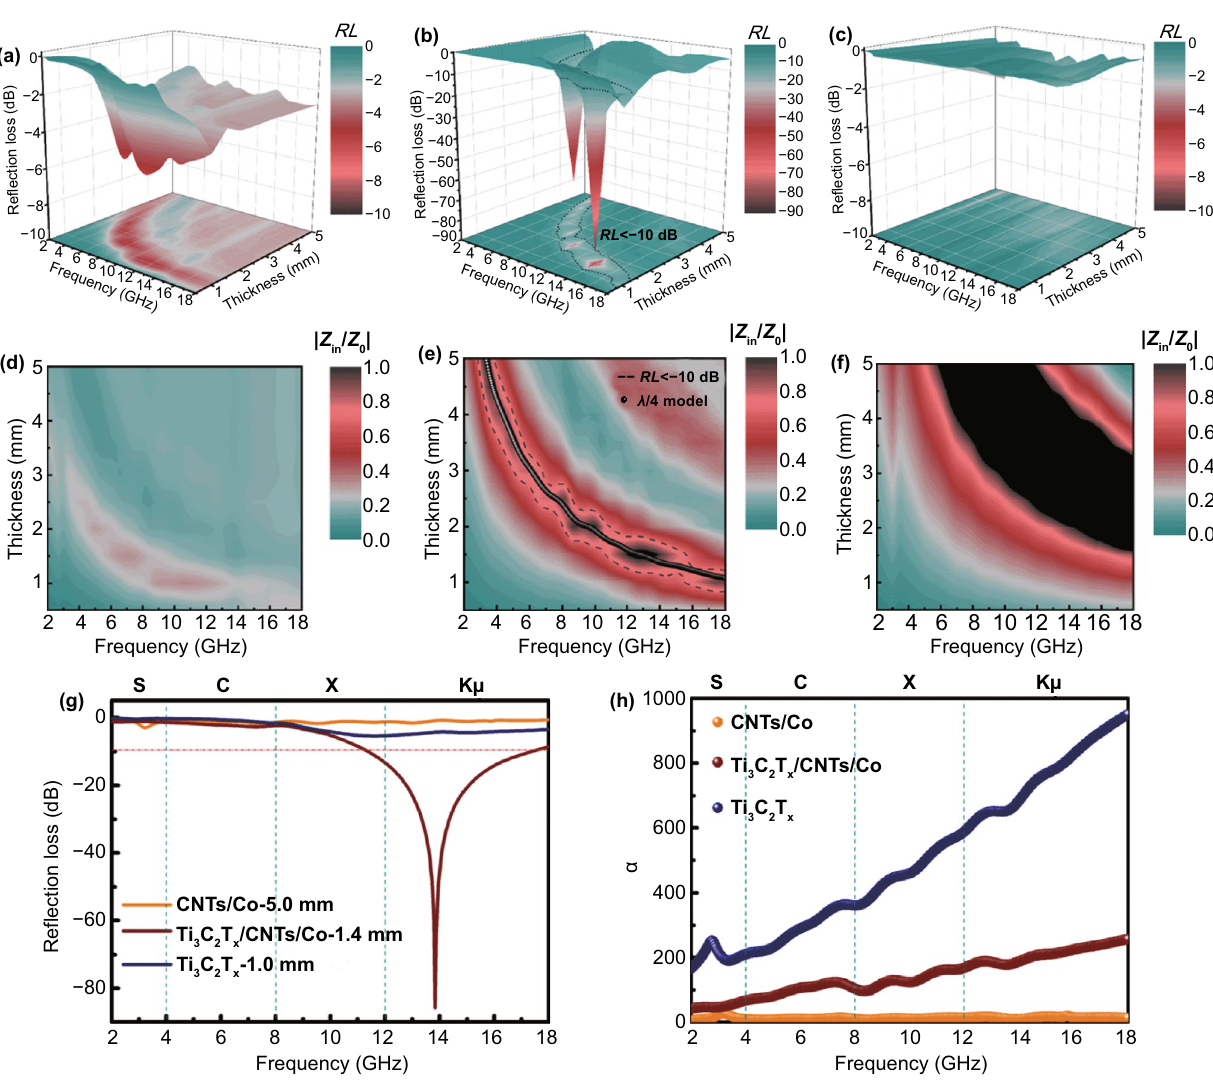
Fig. 3 3D representations of RL values for ( a ) Ti 3 C 2 T x , ( b ) Ti 3 C 2 T x /CNTs/Co, and ( c ) CNTs/Co. 2D contour map representation of modulus of relative input impedance (| Z in / Z 0 |) for ( d ) Ti 3 C 2 T x , ( e ) Ti 3 C 2 T x /CNTs/Co, and ( f ) CNTs/Co. ( g ) The RL curves of CNTs/Co-5.0 mm, Ti 3 C 2 T x / CNTs/Co-1.4 mm, and Ti 3 C 2 T x -1.0 mm. ( h ) The attenuation constant ( α ) of Ti 3 C 2 T x , Ti 3 C 2 T x /CNTs/Co, and CNTs/Co